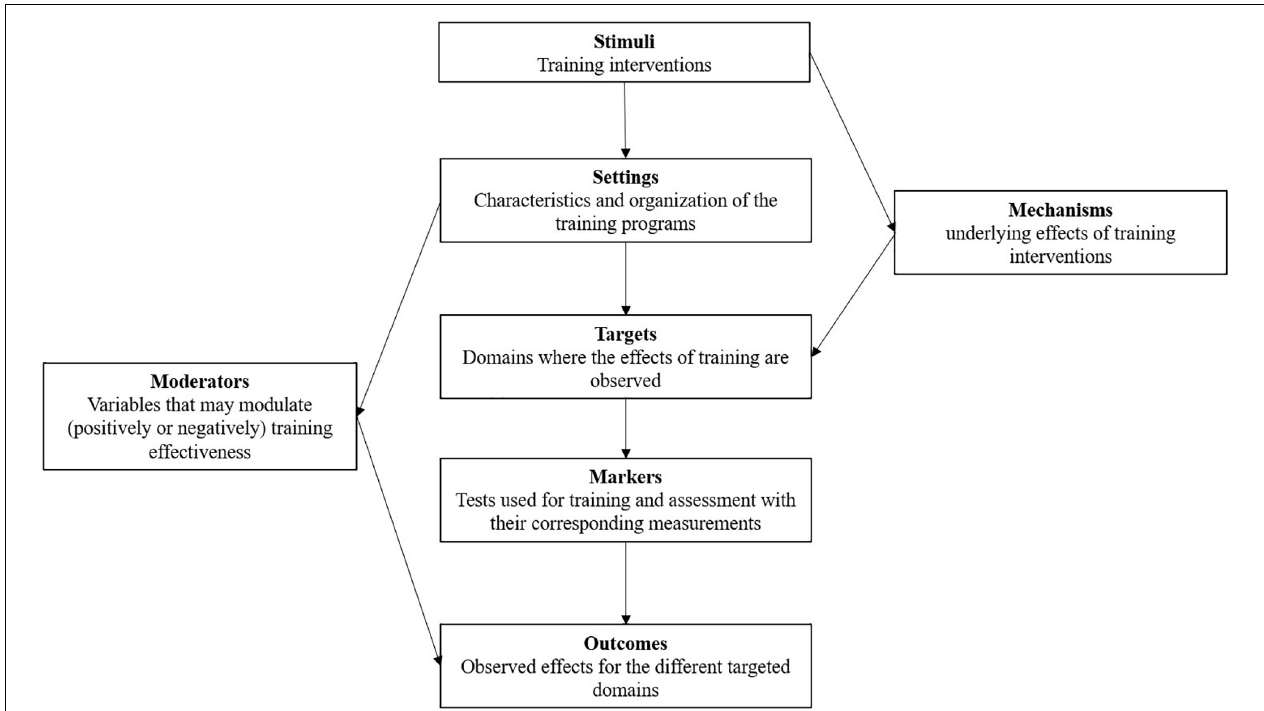
FIGURE 1 | A multi-dimensional analysis of combined training. Detailed explanations are provided in the